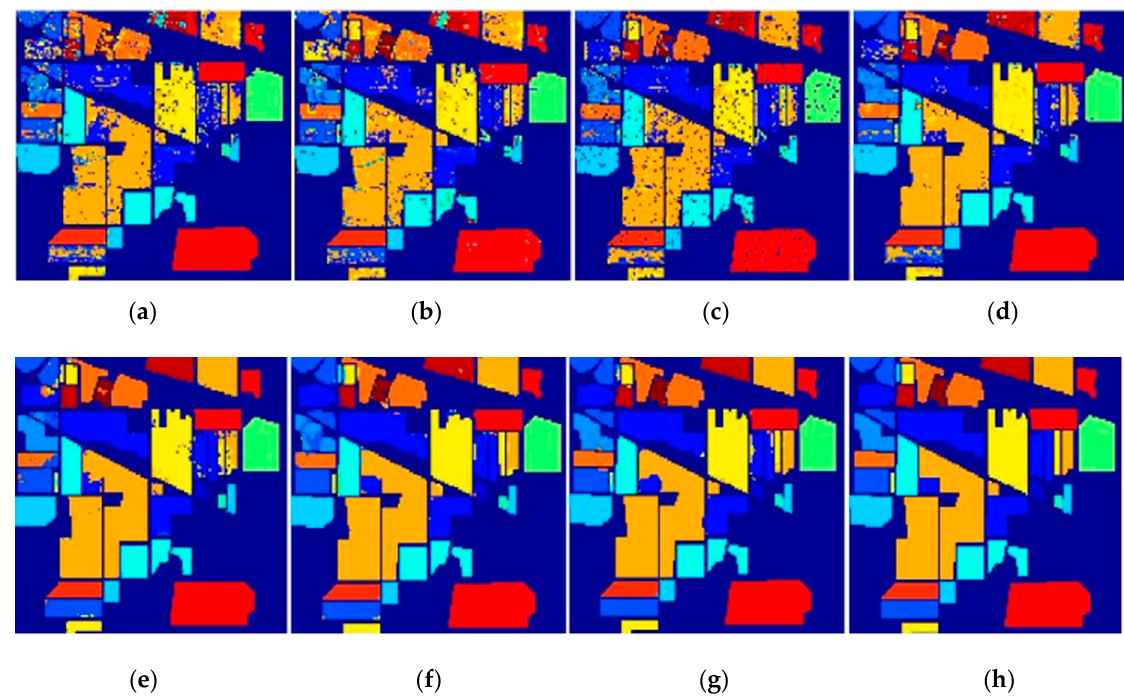
Figure 5. Classification map of the Indian Pines data set with 30 samples: ( a ) ELM, ( b ) KELM, ( c ) WKELM, ( d ) SS-KELM, ( e ) KELM-CK, ( f ) ASS-H-DELM, ( g ) HCKBoost, and ( h ) DW-KELM.